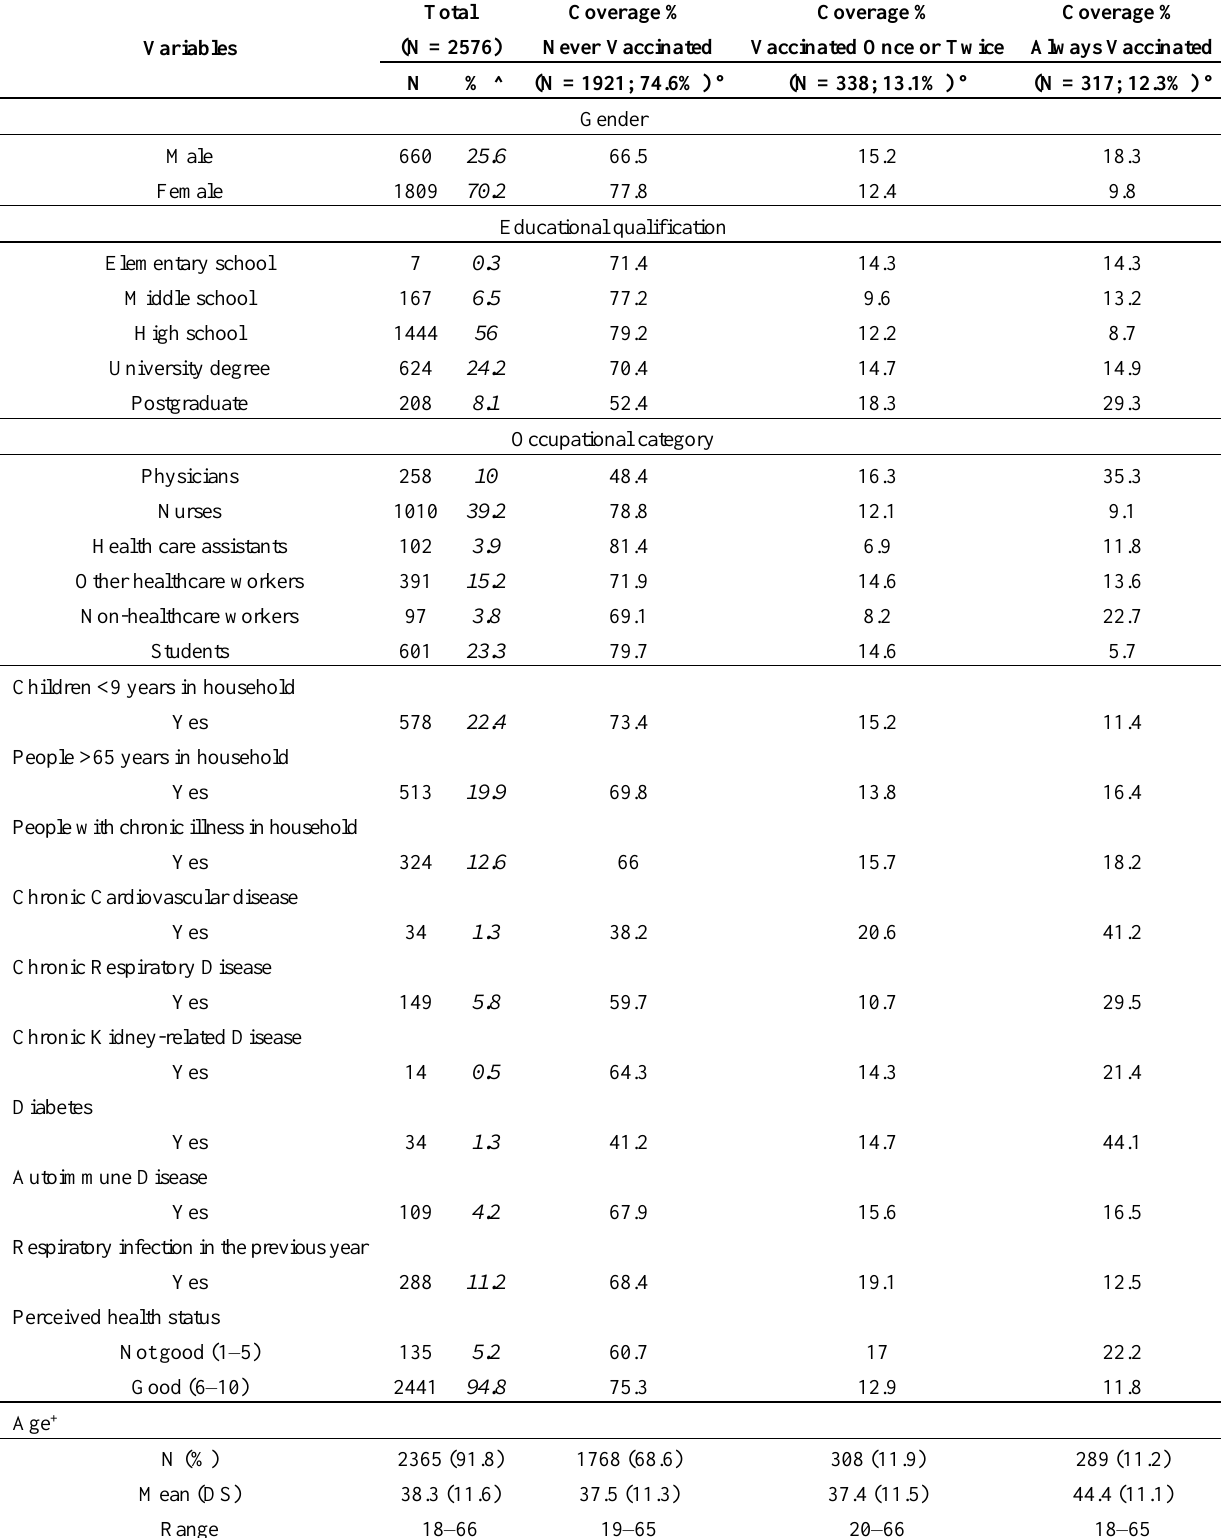
Table 1. Seasonal influenza vaccination coverage from 2007–2008 to